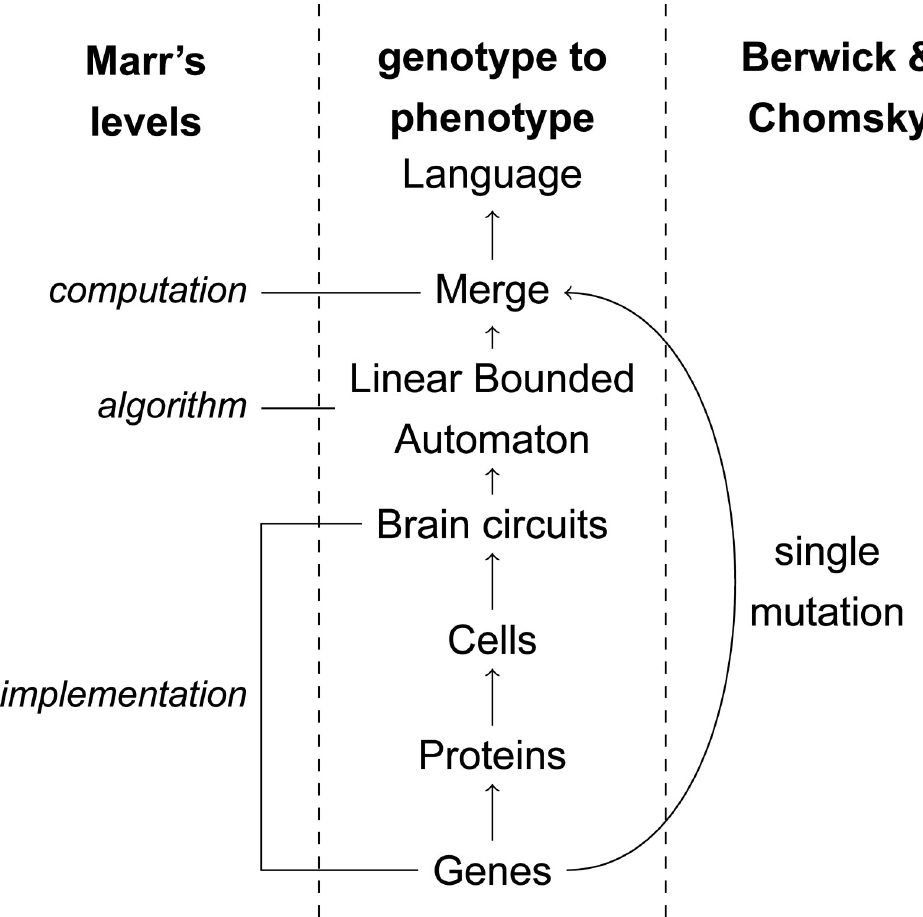
Fig 2. Berwick and Chomsky’s theory of language evolution in the context of Marr’s levels.